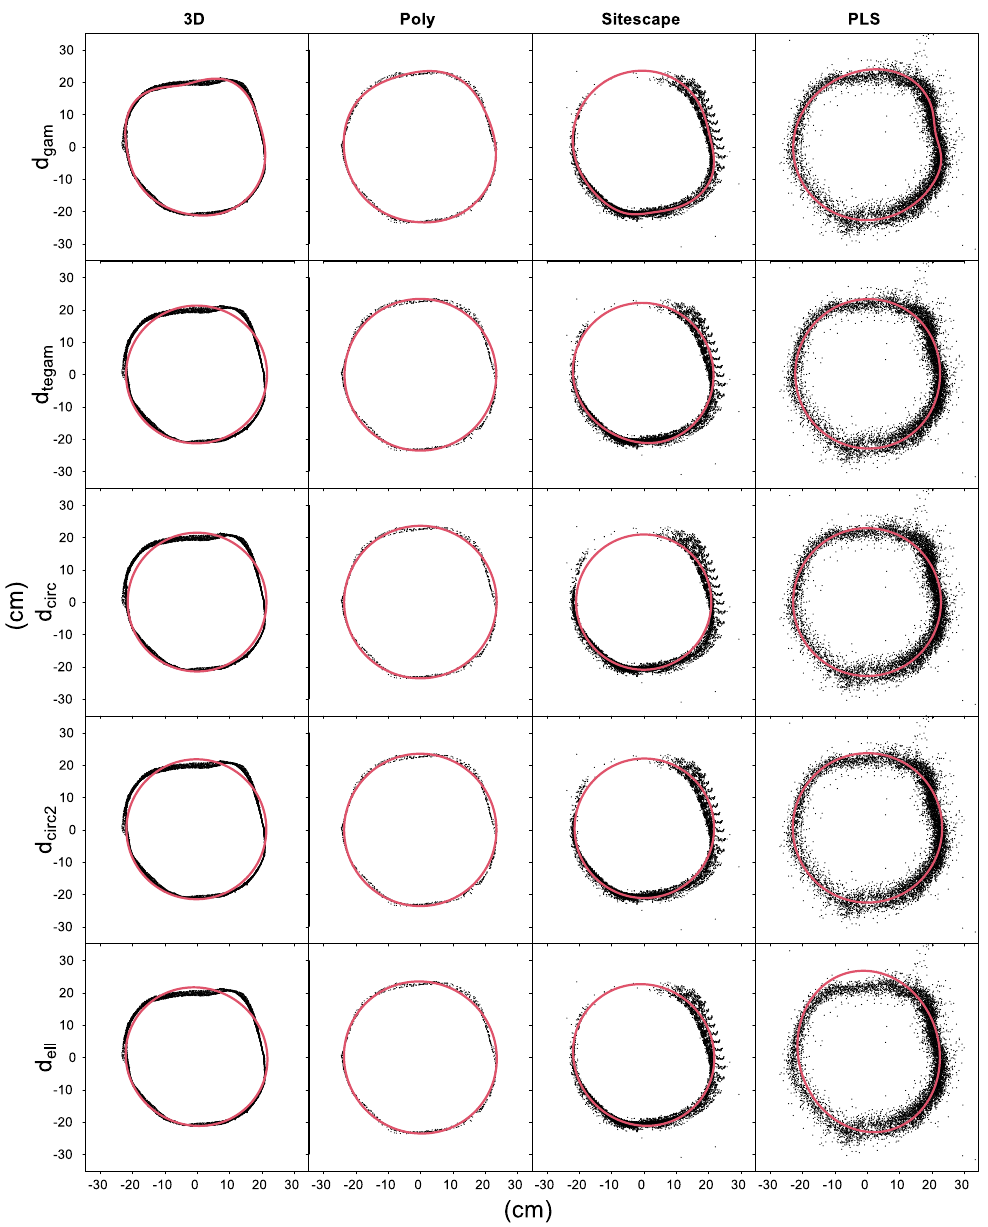
Figure 5. Cross-section at breast height (1.3 m above the ground) of one exemplarily tree, obtained with the three different iPad apps and PLS and with different diameter fitting approaches. Table 2. Overview of the objects in terms of shape, material, and